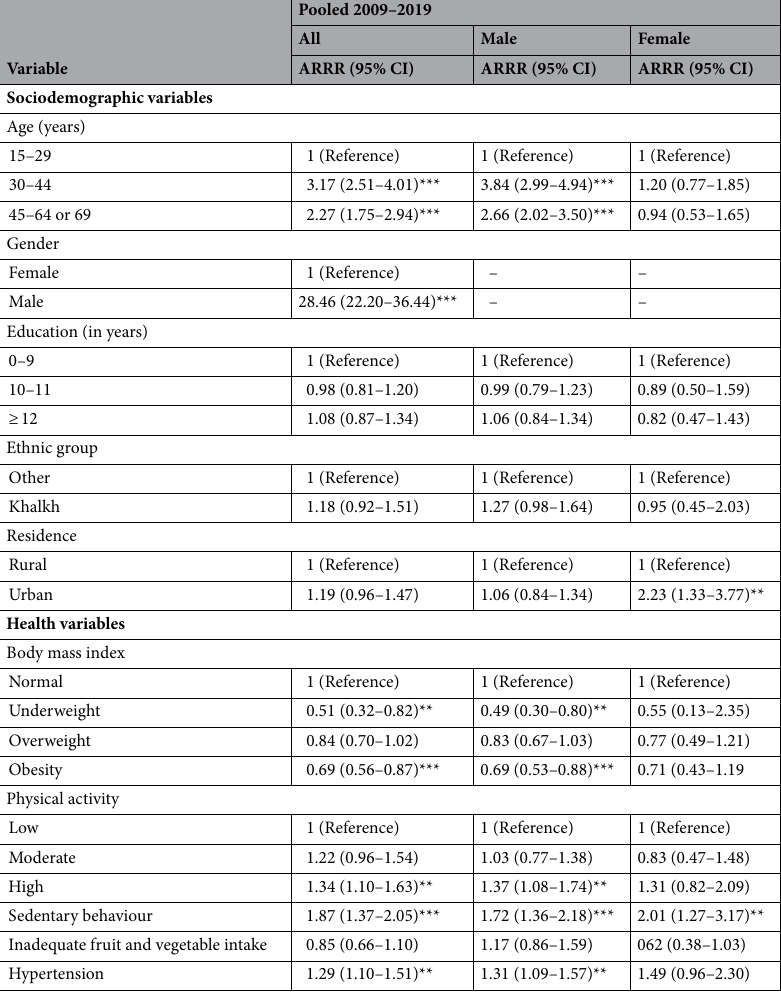
Table 19. Associations with current tobacco use and current heavy drinking (with non-current tobacco and non-current heavy drinking as reference category) among 15 years and older individuals in